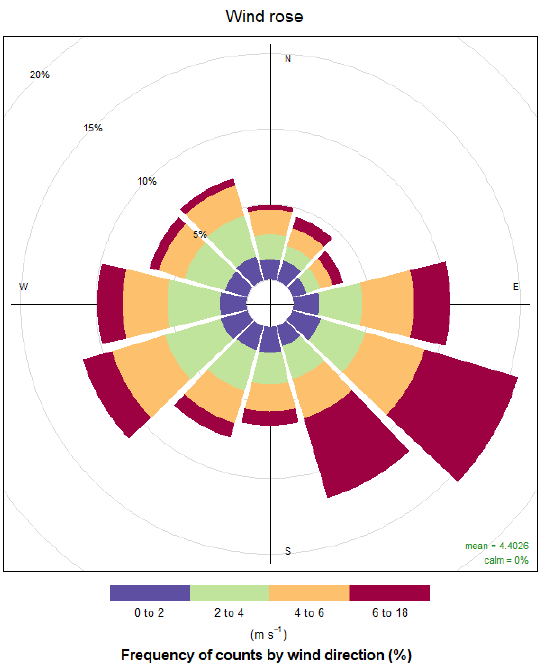
Figure 5. Wind roses for September and December 2019; values were measured at 86 m above the ground level.